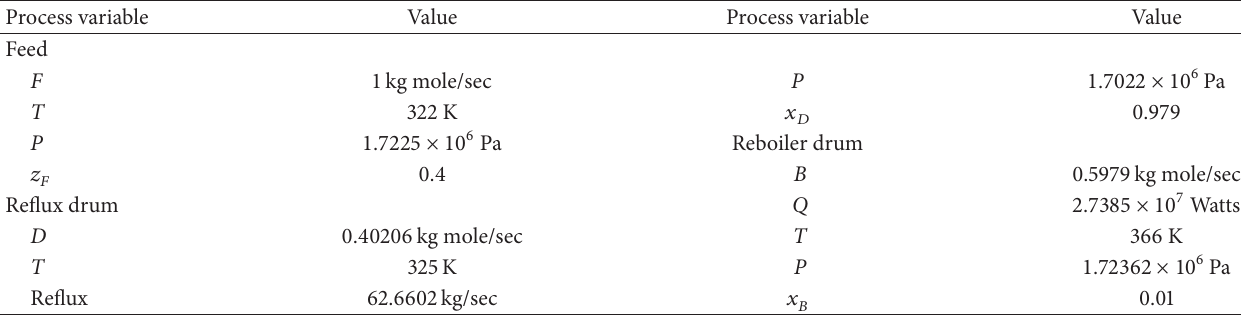
Table 2: Steady state operating conditions of the distillation column.